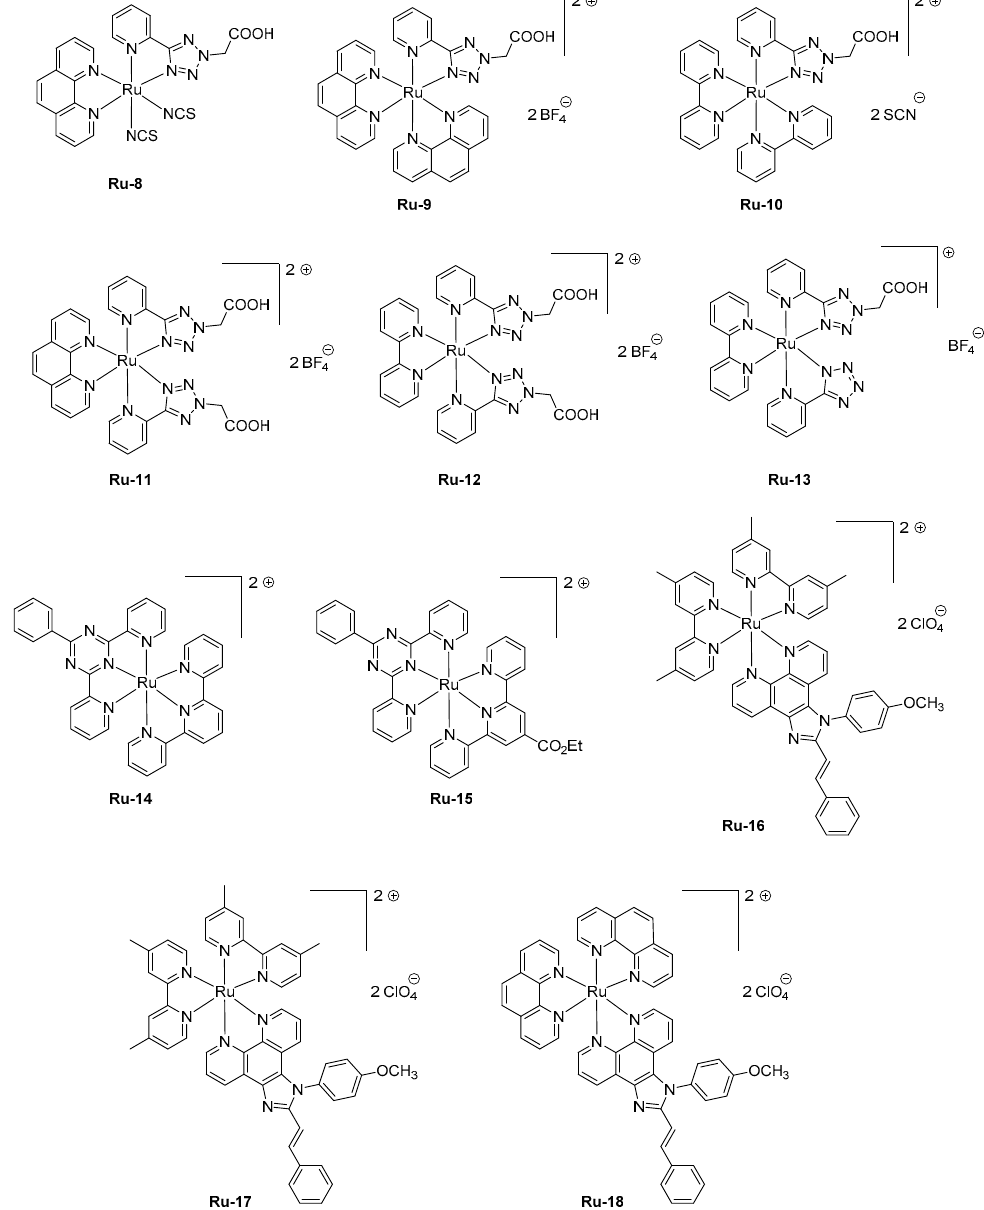
Figure 6. Ru-based near-infrared (NIR) emitters for light-emitting electrochemical cells.